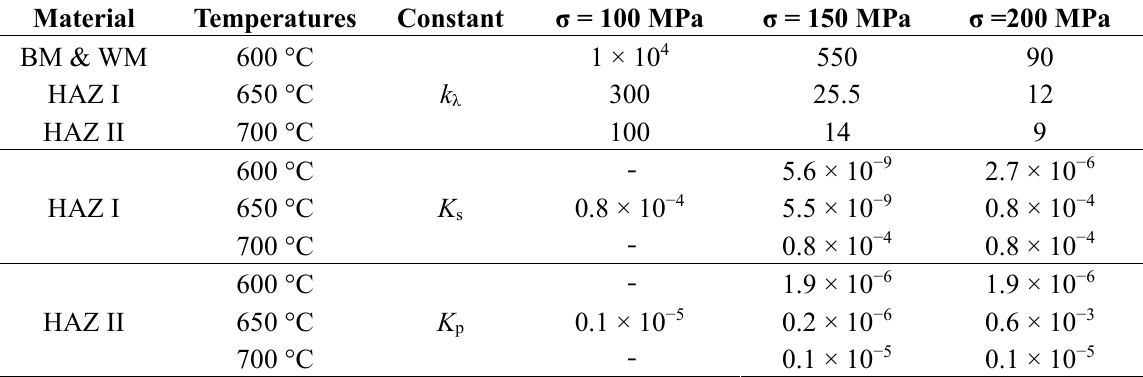
Table 3. Material constants used in the constitutive